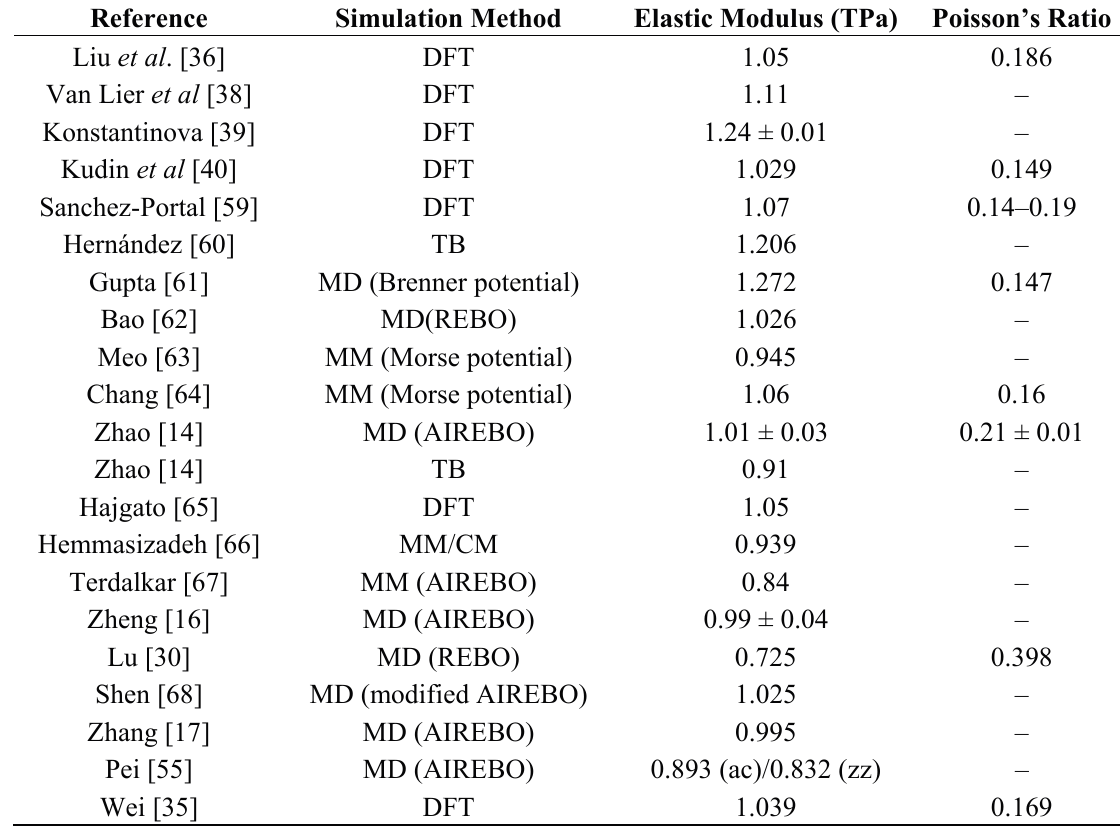
Table 1. Elastic modulus and Poisson’s ratio of graphene calculated by atomistic